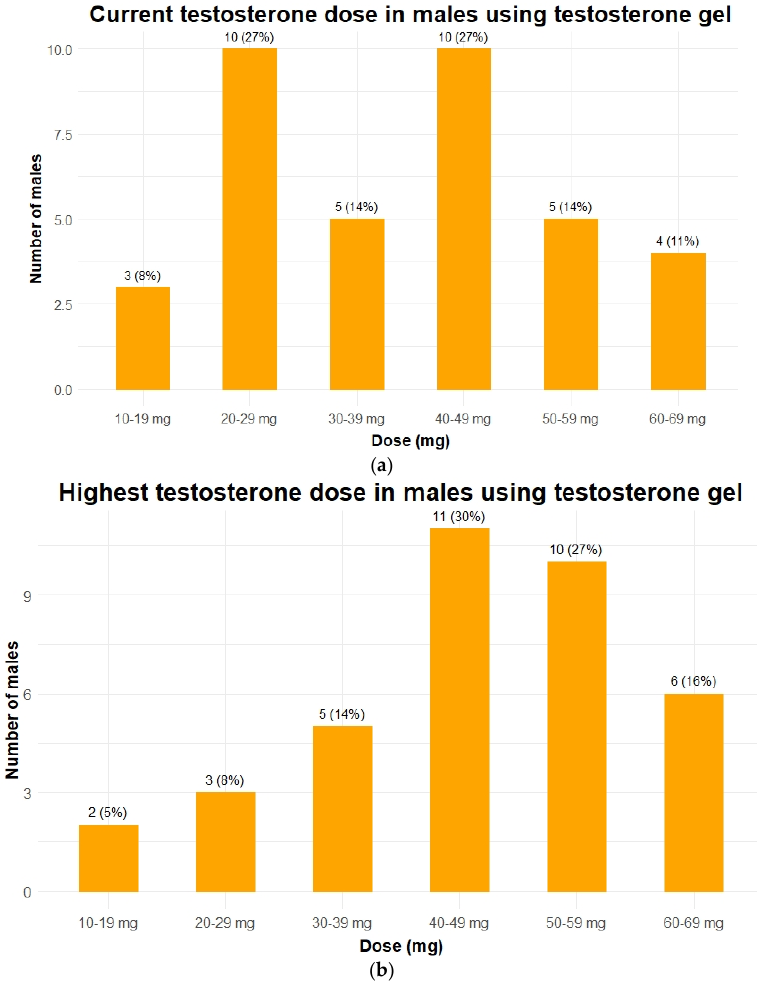
Figure 1. Testosterone dose in 37 males with PWS using testosterone gel. Data is given as n (%). ( a ) The testosterone doses each patient received during the last visit to the outpatient clinic. When patients died or were transferred to another hospital, the last known dose was given; ( b ) the highest dose of testosterone gel ever received while visiting our outpatient clinic for each patient. To make both graphs comparable only patients who currently still use testosterone gel are depicted in panel b (in 5 patients testosterone replacement therapy was discontinued completely).